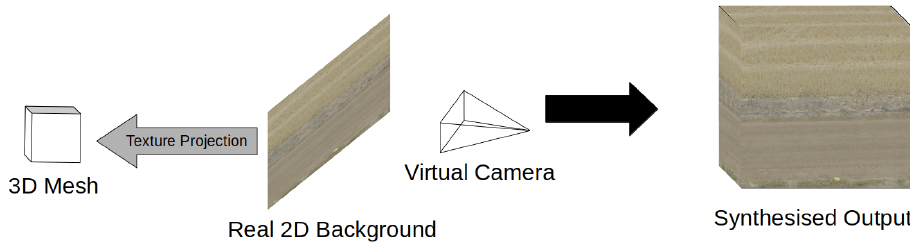
Figure 3. Synthesis via projection of real 2D image onto 3D mesh.